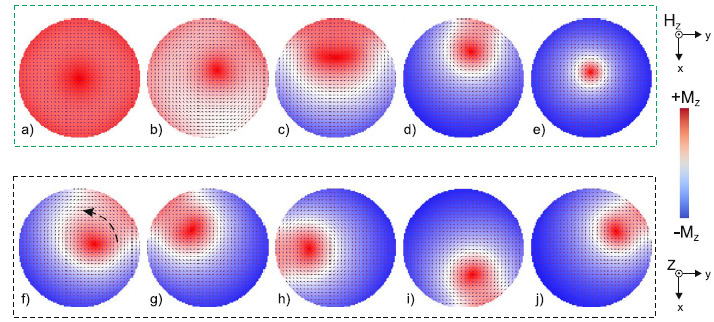
Figure 11. Result of calculation. Sections of microwire ( a – e ) fixed position Z = 5.27 µm and varying axial field. Hax ( a ) 28 Oe, ( b ) 15 Oe, ( c ) 0, ( d ) − 28 Oe and ( e ) − 40 kA/m. ( f – j ) fixed axial field Hax = − 30 kA/m and varying position. Z ( f ) 0.64 µm, ( g ) 1.85 µm, ( h ) 2.43 µm, ( i ) 3.65 µm and ( j ) 4.82 µm. Reprinted with permission from [54].